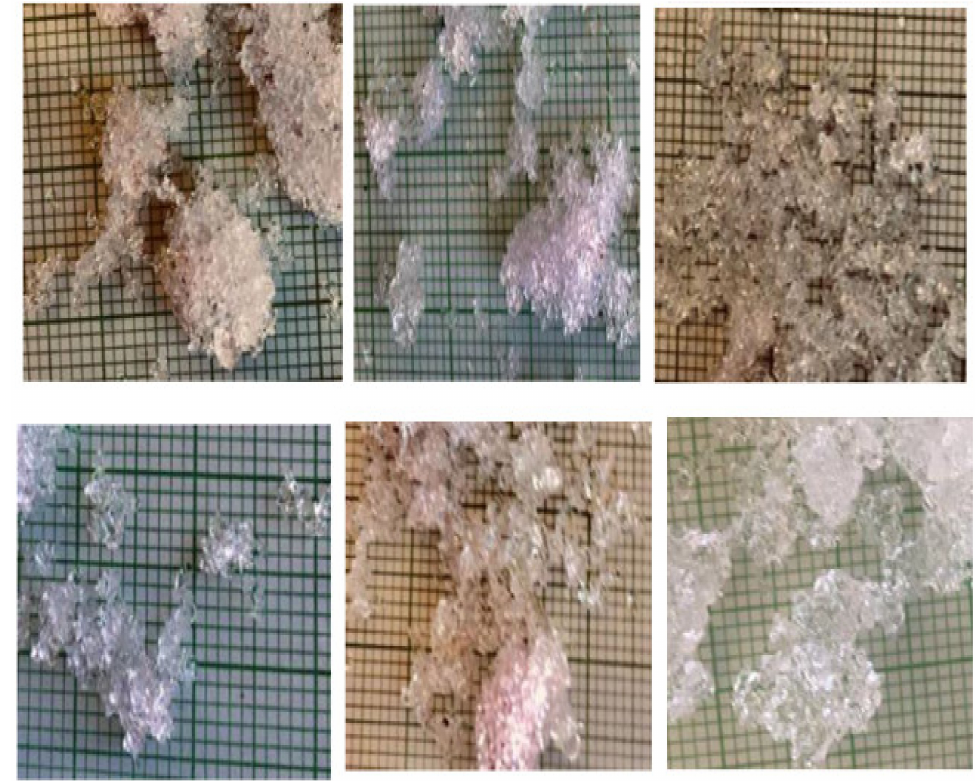
Figure 17. Snow grains from the strongly metamorphosed